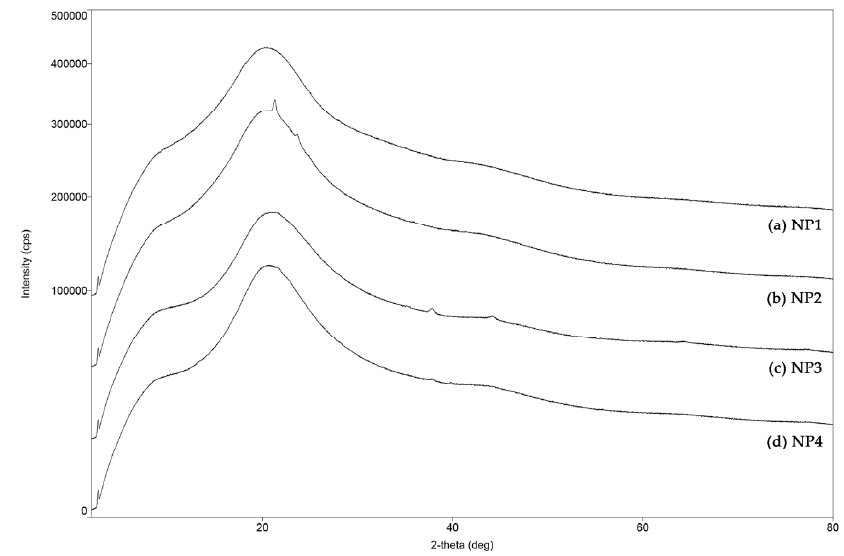
Figure 3. X-ray diffraction (XRD) characterization of NPs (a) NP1, (b) NP2, (c) NP3, (d) NP4. Diffraction patterns were scanned between 2 and 80°/2 θ .